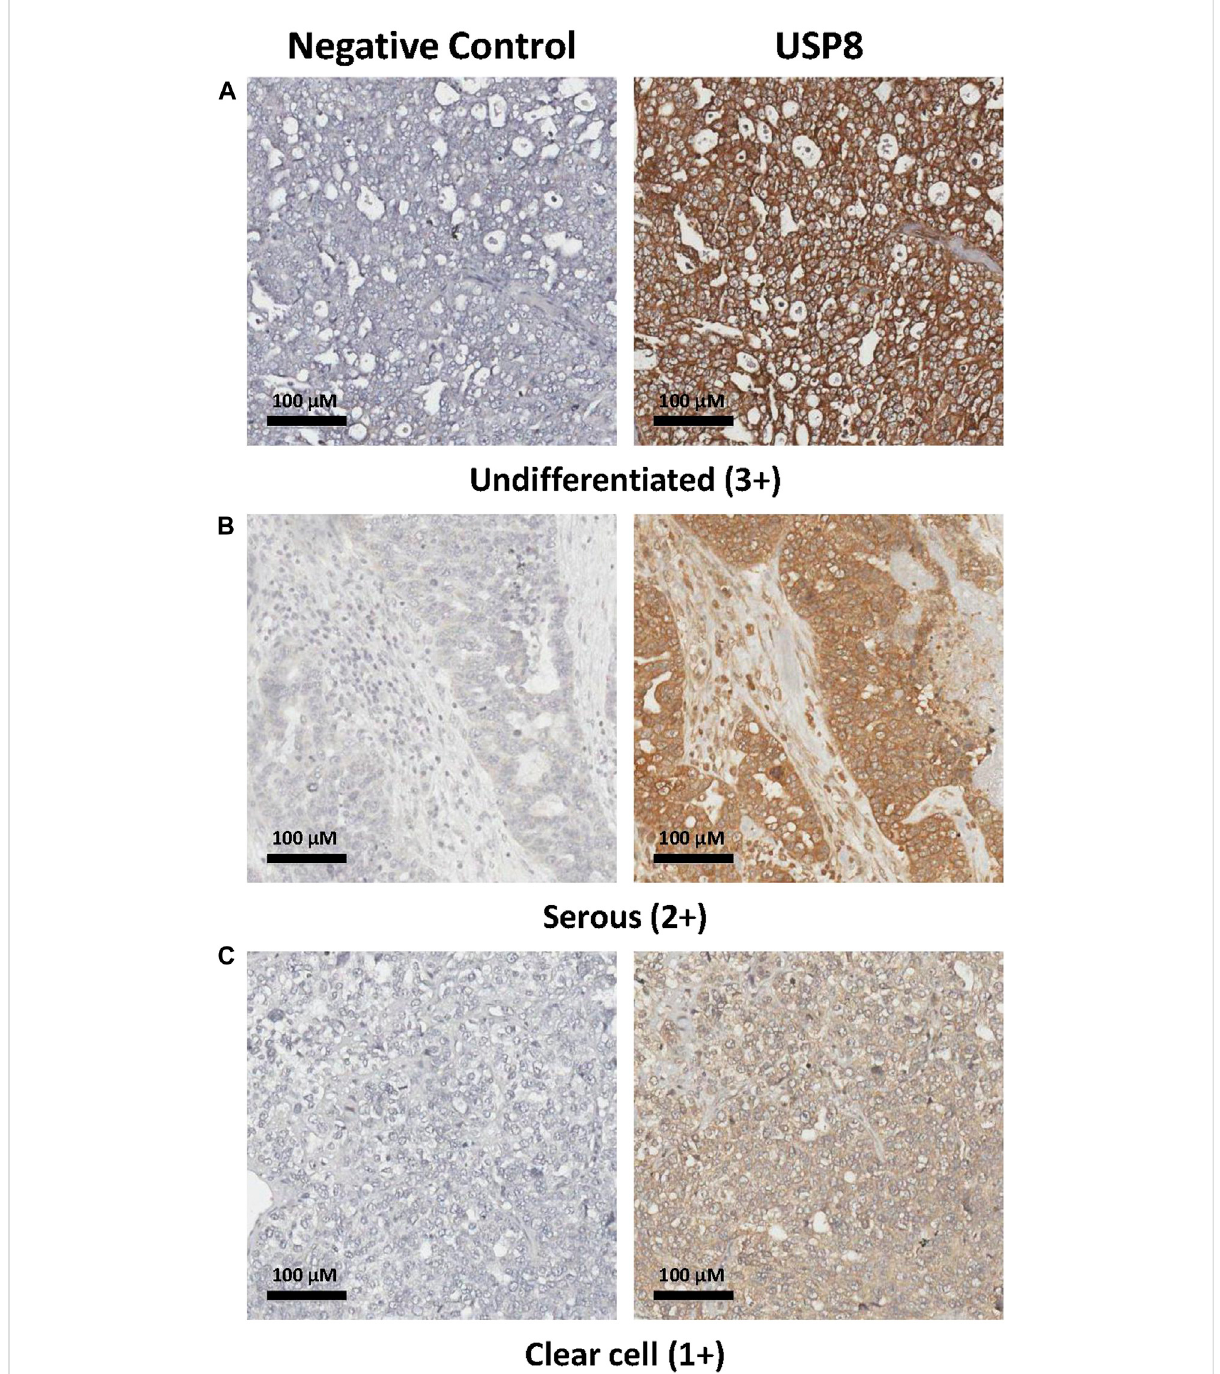
FIGURE 6 Immunohistochemical evaluation of USP8 in ovarian carcinoma specimens. (A) Representative image of an undifferentiated case with high intensity staining (3+), showing that the protein of interest was present both at the plasma membrane and in the cytoplasm. (B) Image of a serous ovarian carcinoma withmedium intensity staining(2+); (C) Imageofaclear cellcarcinoma withlowintensitystaining(1+).Allsamplesarefromstage III patients. Images showing that the protein of interest was present both at the plasma membrane and in the cytoplasm are reported. Negative control, slides incubated with secondary antibody